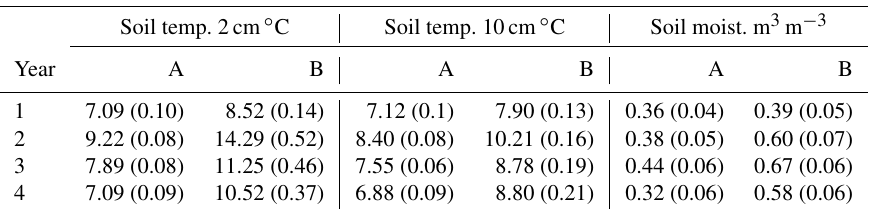
Table 1. Annual mean of eight replicate measurements ( ± SE) of soil temperatures at 2 and 10cm depths and moisture at 6cm depth measured close to the soil GHG flux chambers in area A (mature spruce stand, remaining) and area B (mature spruce stand, clear-felled after year 1) in Harwood Forest. Significance p values are all < 0 . 01.